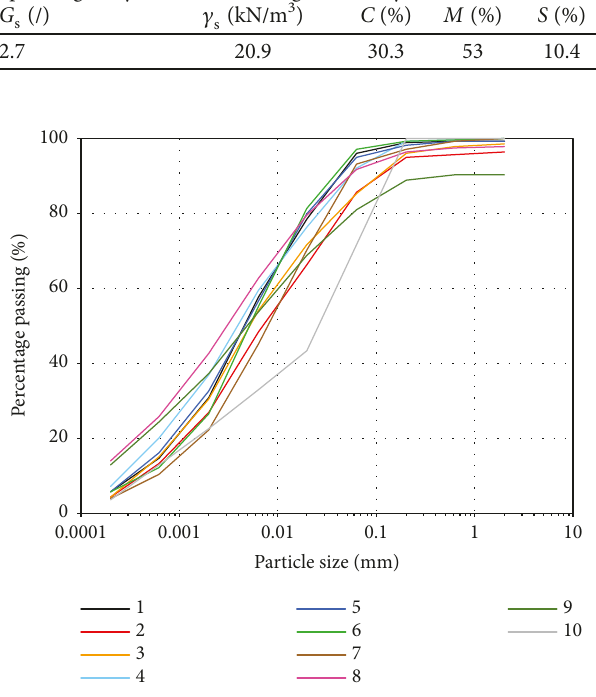
Figure 3: GSD results for samples collected at 10 locations along the landslide body and slope.